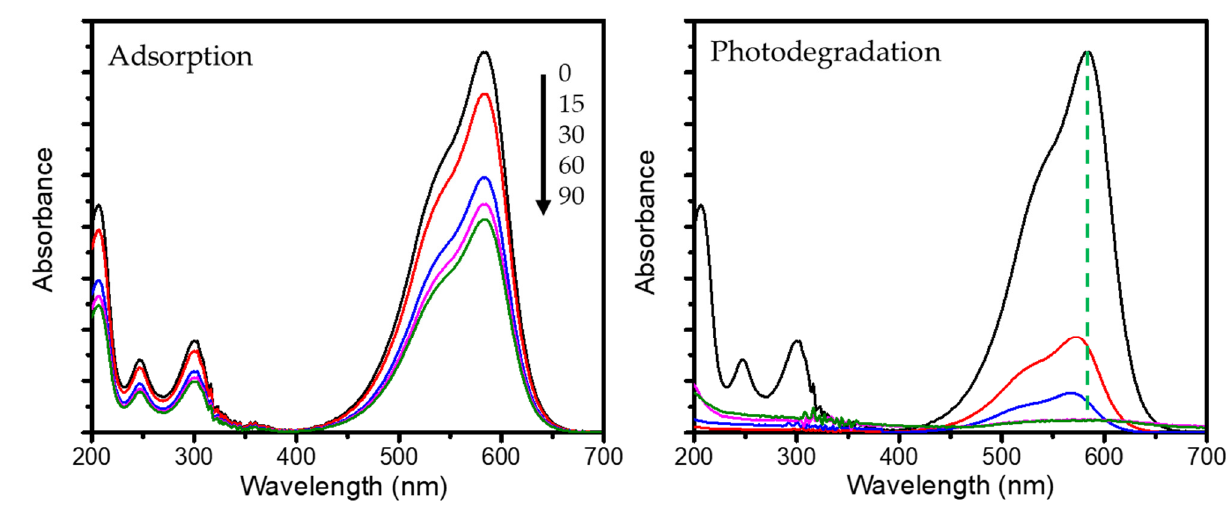
Figure 9. Comparison of UV-Visible spectra of treated solution by adsorption and photodegradation mechanism.